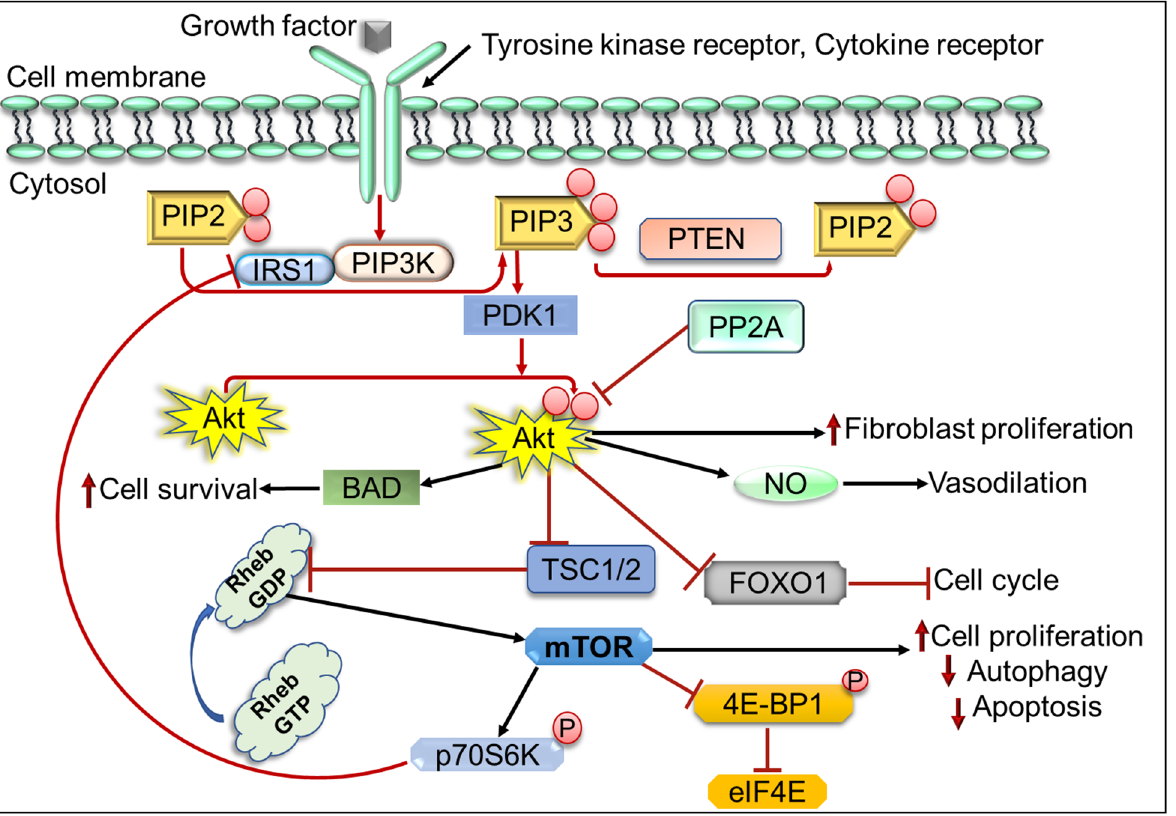
Figure 2. Schematic overview of PI3K/Akt/mTOR pathway. BAD, BCL2 associated agonist of cell death; FOXO1, Forkhead box O1 protein; IRS1, Insulin receptor substrate 1; 4EBP1, Eukaryotic translation initiation factor 4E-binding protein 1; p70S6K1, p70 Ribosomal S6 kinase 1; PIP2, Phosphatidylinositol 4,5-bisphosphate; PTEN, Phosphatase, and tensin homolog deleted on chromosome 10; PDK1, 3-Phosphoinositide-dependent kinase 1; PP2A, Protein phosphatase 2A; Rheb GDP, Ras homolog enriched in brain GDP; Rheb GTP, Ras homolog enriched in brain GTP and TSC, Tuberous sclerosis complex.